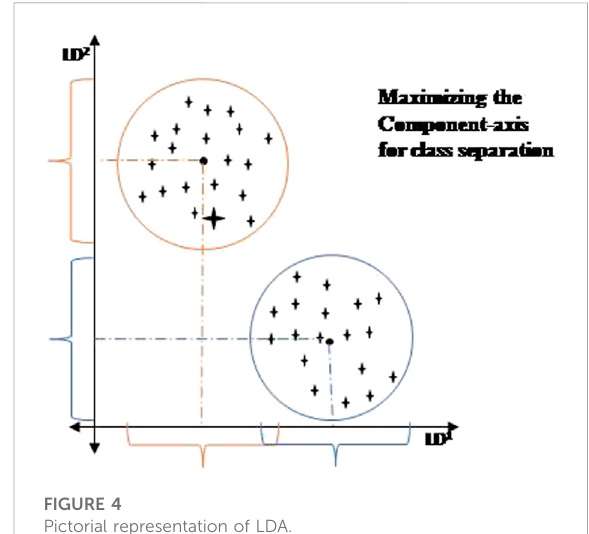
FIGURE 4 Pictorial representation of LDA.